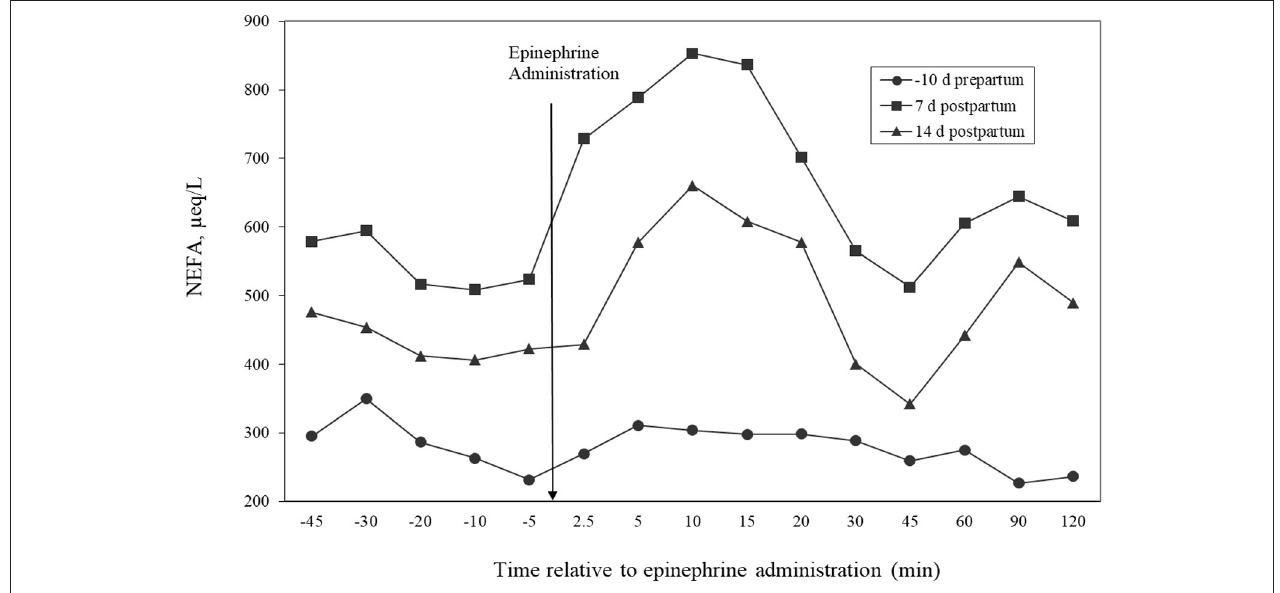
FIGURE 3 | Temporal patterns of concentrations of non-esterified fatty acids (NEFAs) in plasma relative to administration of epinephrine for cows administered epinephrine challenges at days − 10, 7, or 14 relative to calving. Effects of day ( P ≤ 0.001) and time relative to epinephrine administration ( P < 0.001).